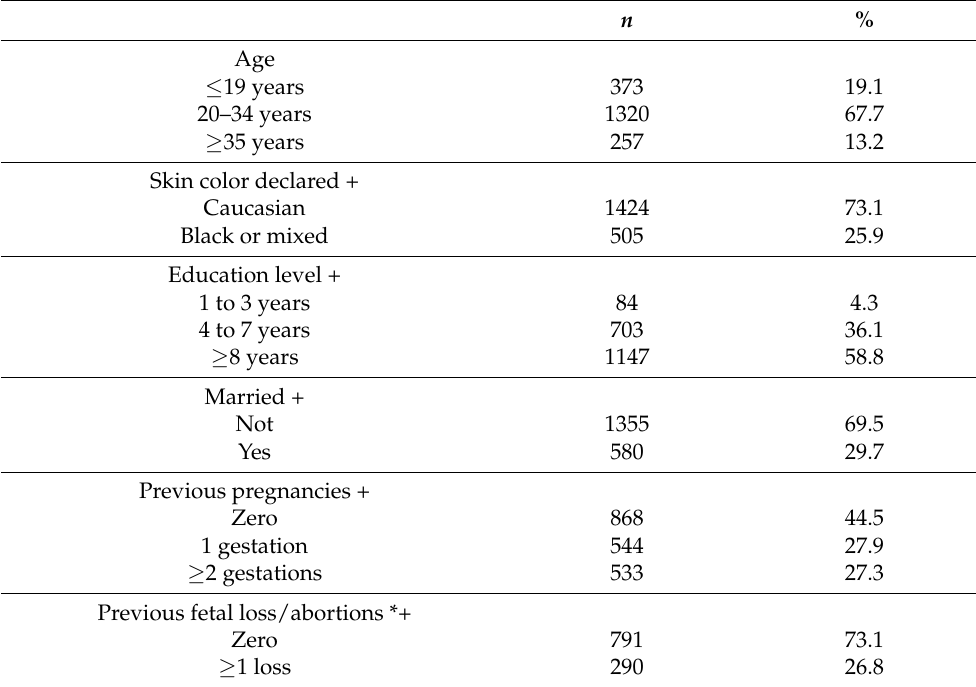
Table 2. Maternal demographics from a coal mining area,